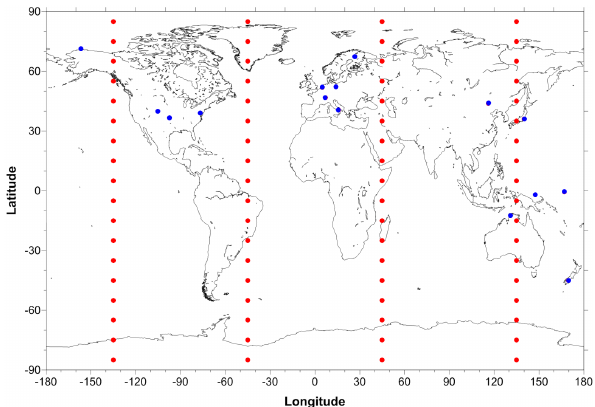
Figure 1. Map of the 87 locations used for the data analysis; 15 of the locations are the initial GRUAN sites (blue dots) and the other 72 of the locations (red dots) are positioned in 90 ◦ longitude zones and 10 ◦ latitude zones as shown on the